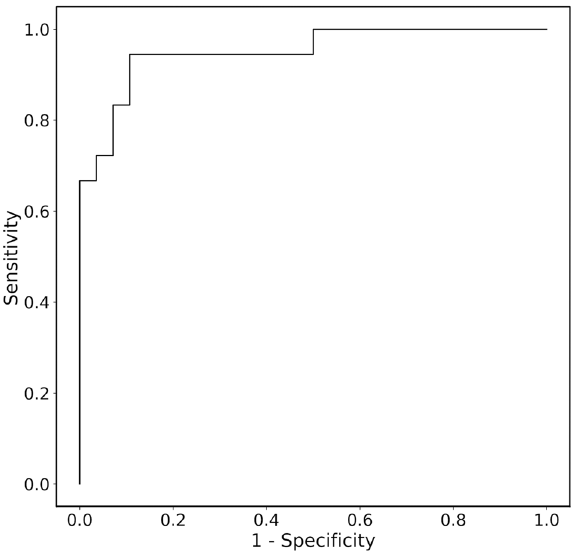
Figure 4. Receiver operating characteristic curve in test dataset (n = 46) for predicting unilateral subtype of primary aldosteronism in feature-selected random forests.